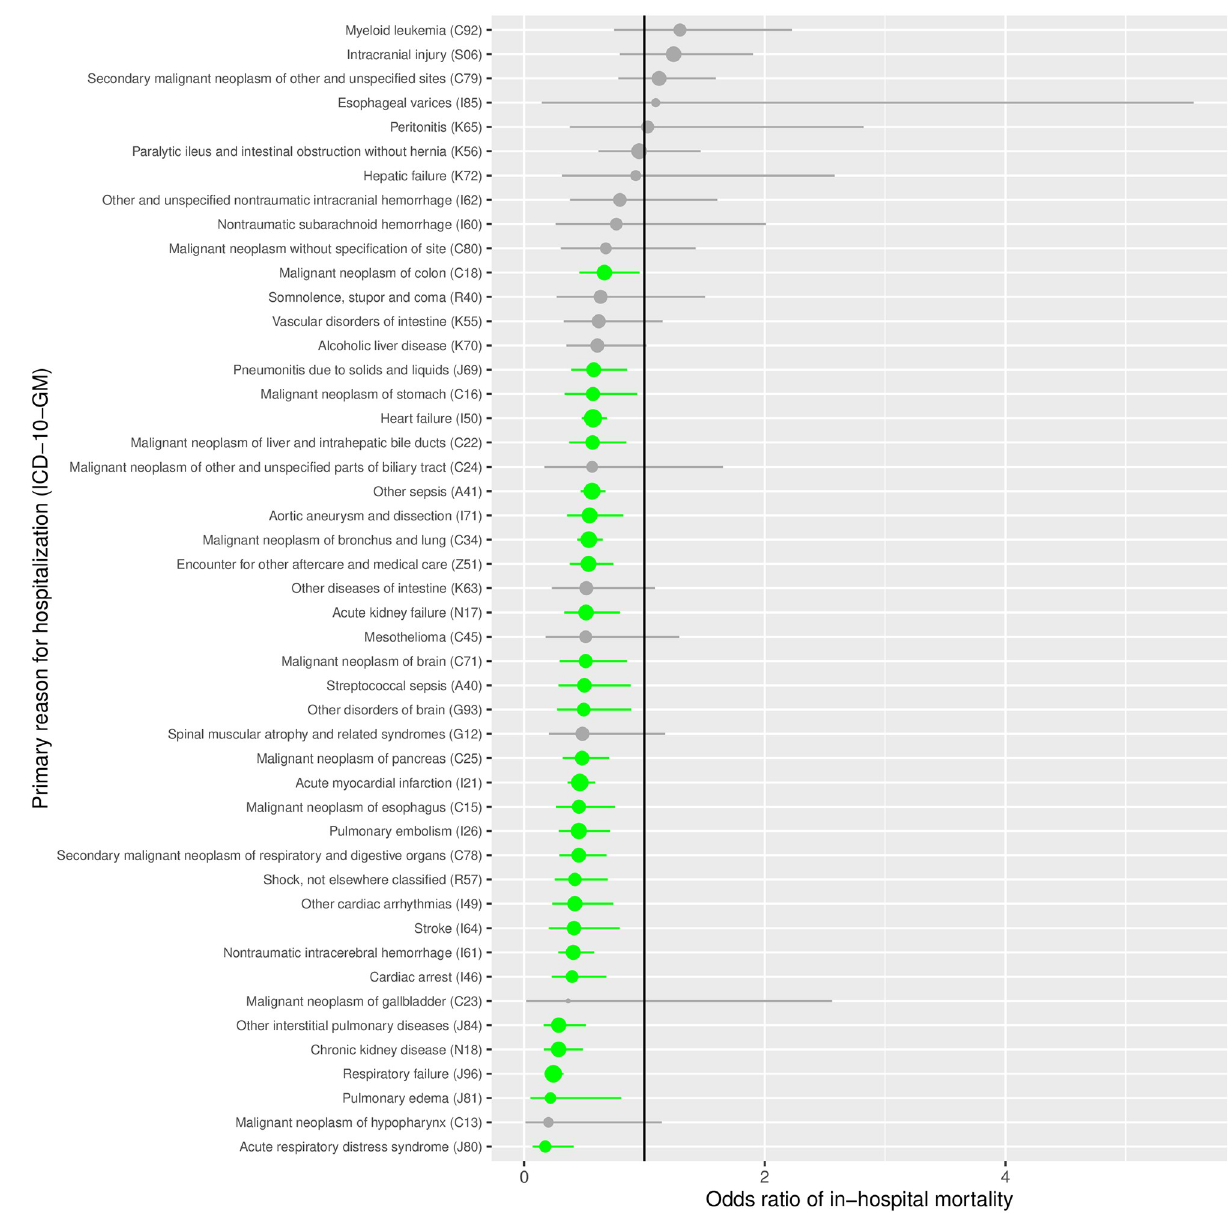
Fig 4. Survival benefit of coded sleep apnea in patients hospitalized with 47 conditions with highest in-hospital mortality. The odds-ratios (and 95% confidence intervals) comparing the in-hospital mortality between SA cases and matched controls are displayed using a forest plot. The estimates are represented by dots whose size is proportional to the prevalence of the condition. Comorbidities significantly associated with a lower rate of in- hospital mortality are shown in green. Comorbidities not significantly associated with in-hospital mortality are shown in gray. The simplified ICD- 10-GM codes including 2 digits are